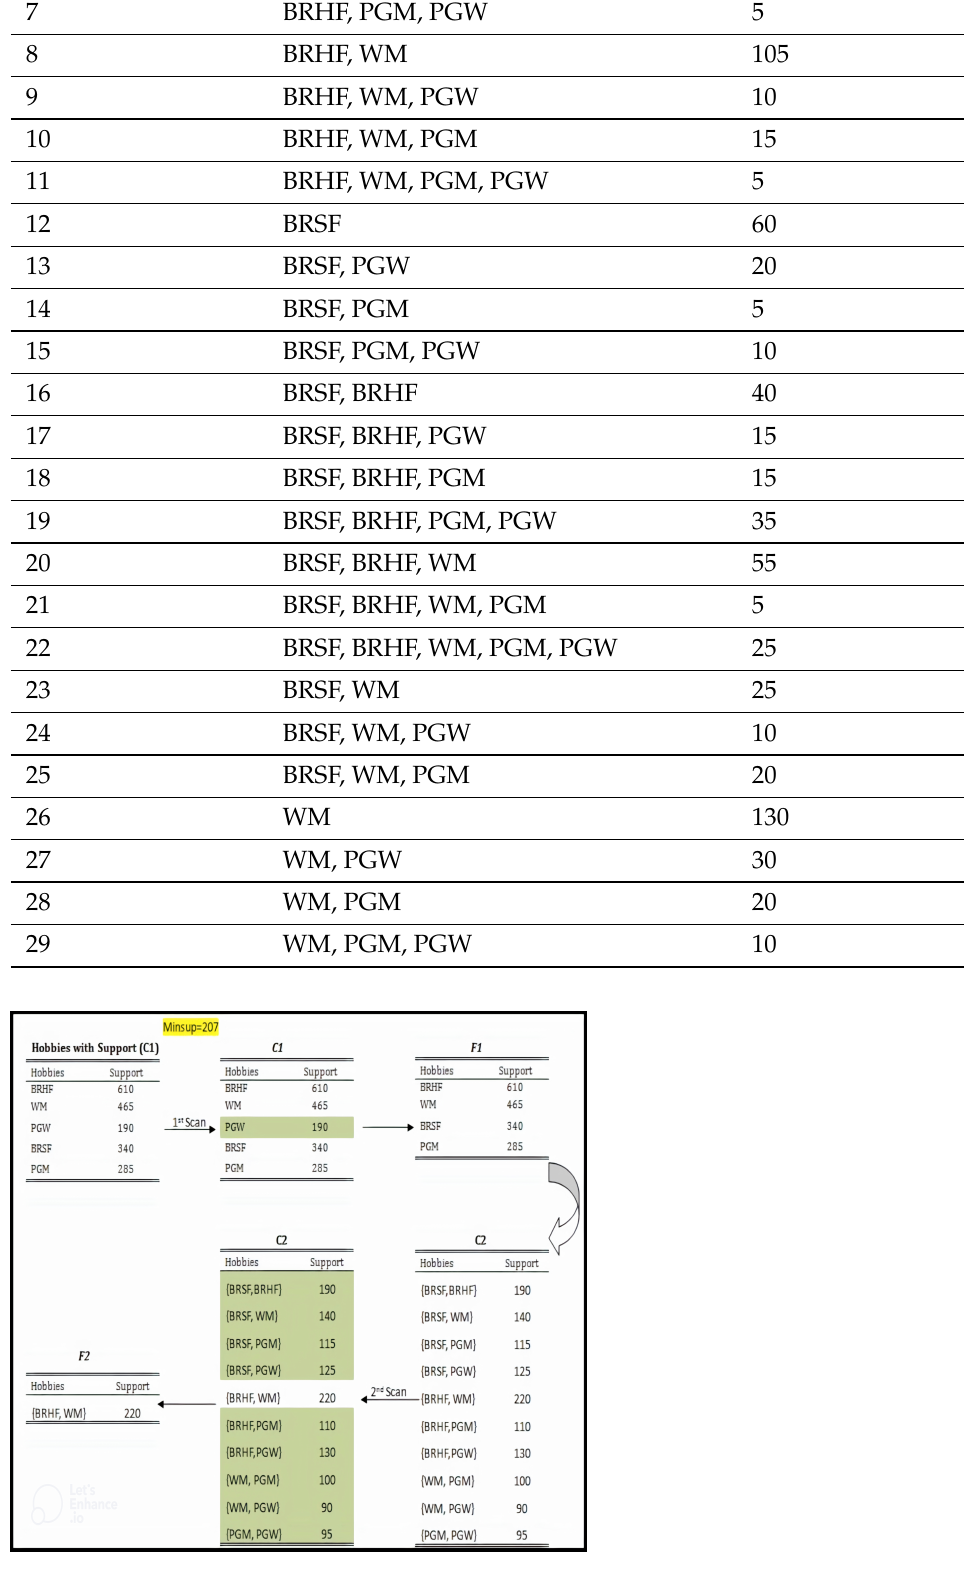
Figure 3. Candidate set C1 and frequent item-set F1 generating Candidate set C2 and frequent item-set